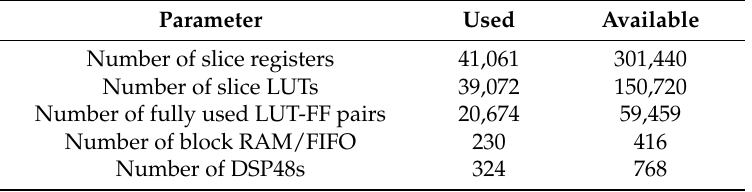
Table 4. Processing times of different systems. CPU: central processing unit; and GPU: graphic processing unit. Platform